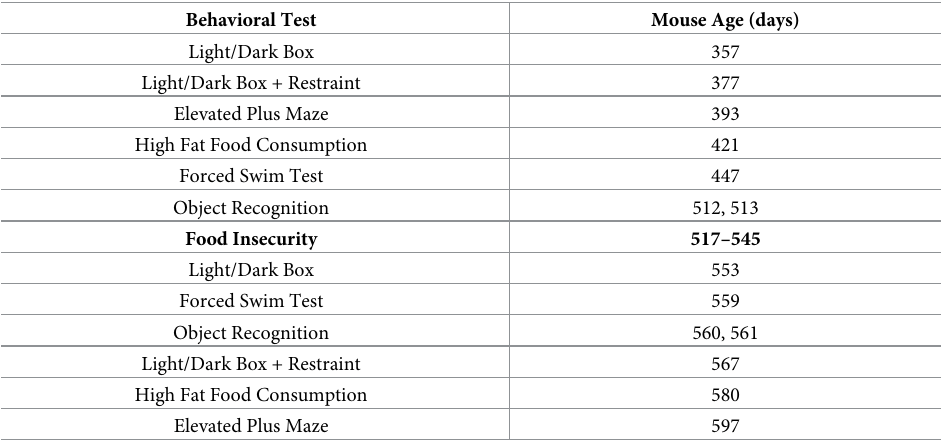
Table 2. Behavioral testing